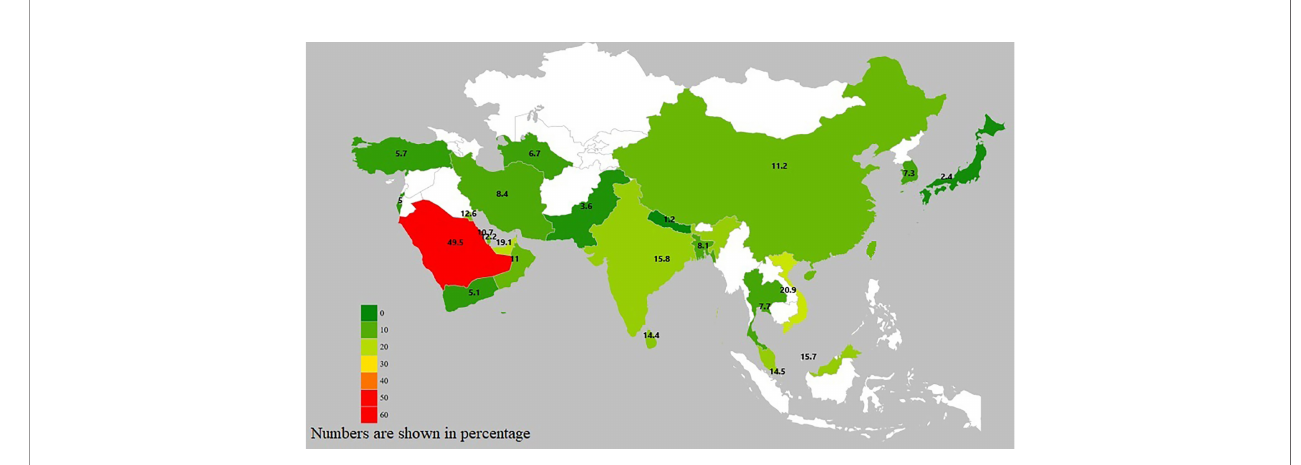
FIGURE 1 | Asian geographic heat map on